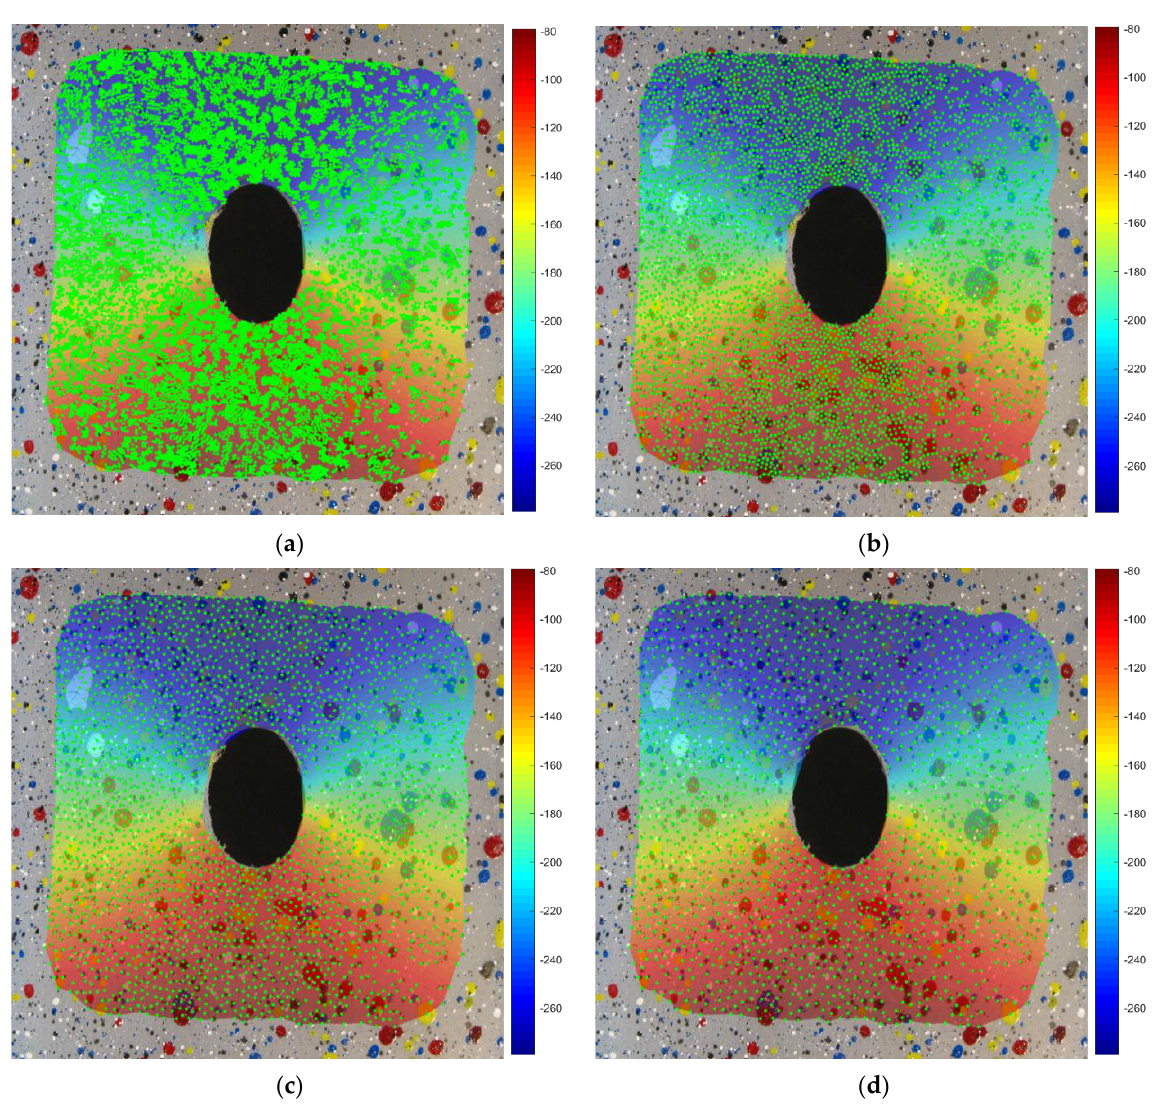
Figure 12. Vertical displacements computed by RBF varying the number of tracked points. ( a ) 10217 points, ( b ) 4149 points, ( c ) 2343 points, ( d ) 1528 points.